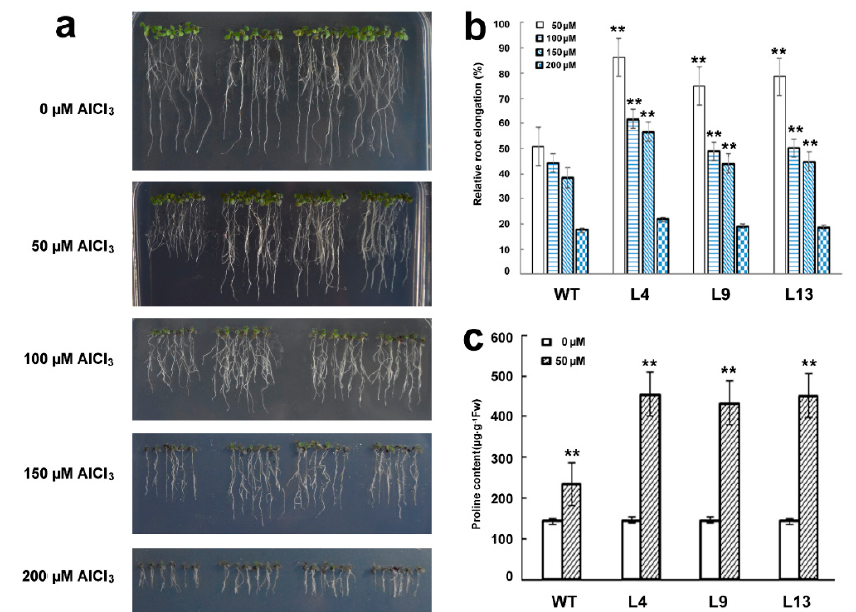
Figure 5. GsMAS1 enhanced the resistance of Arabidopsis plants to Al stress ( a ) The phenotypes of GsMAS1 transgenic lines tolerant to Al stress. ( b ) Statistical analysis of relative root elongation. ( c ) The determination of free proline content. WT: wild type of Arabidopsis (Col-0); L4, L9, L13: GsMAS1 overexpression transgenic lines of T 3 generations. The two-day seedlings after seed germination were transferred to culture medium containing AlCl 3 (pH 4.3, 0.5 mM CaCl 2 ) at 0, 50, 100, 150, and 200 µ M, individually. After being cultured for seven days, phenotypic images and contents of free proline for the GsMAS1 transgenic lines were recorded and / or determined for statistical analysis. Data were represented as the means ± SE of three biological replicates (Student’s test, ** p = 0.05). The programs of Image J, SPSS20, and EXCEL2000 were used to measure and / or analyze the data.